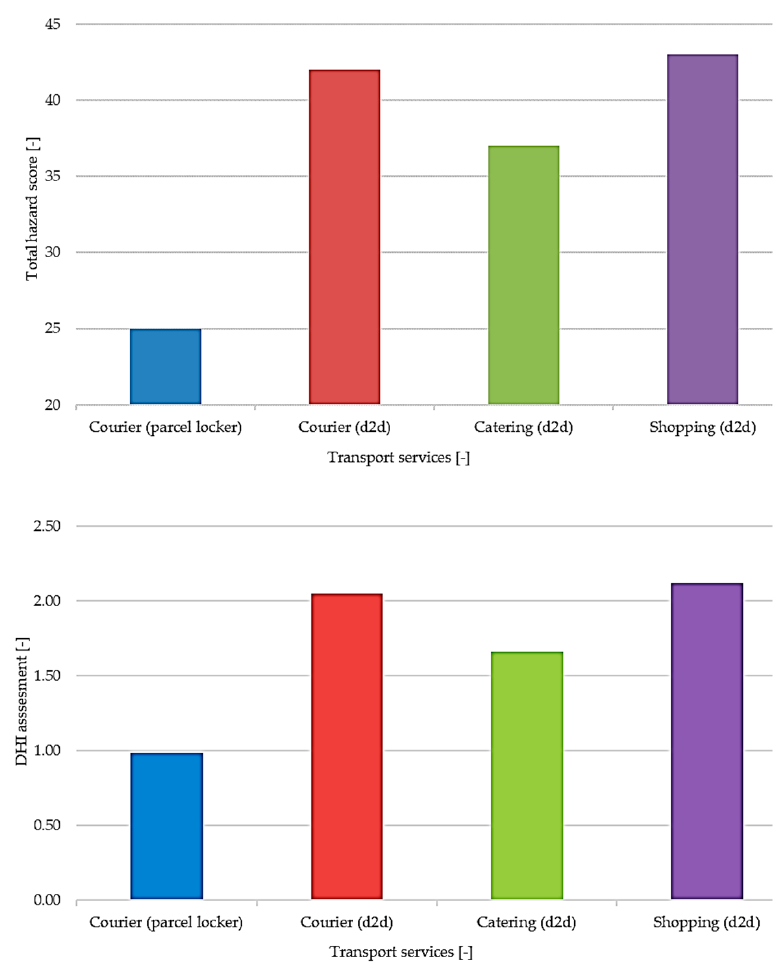
Figure 7. Comparison of total hazard assessment and DHI indexes.